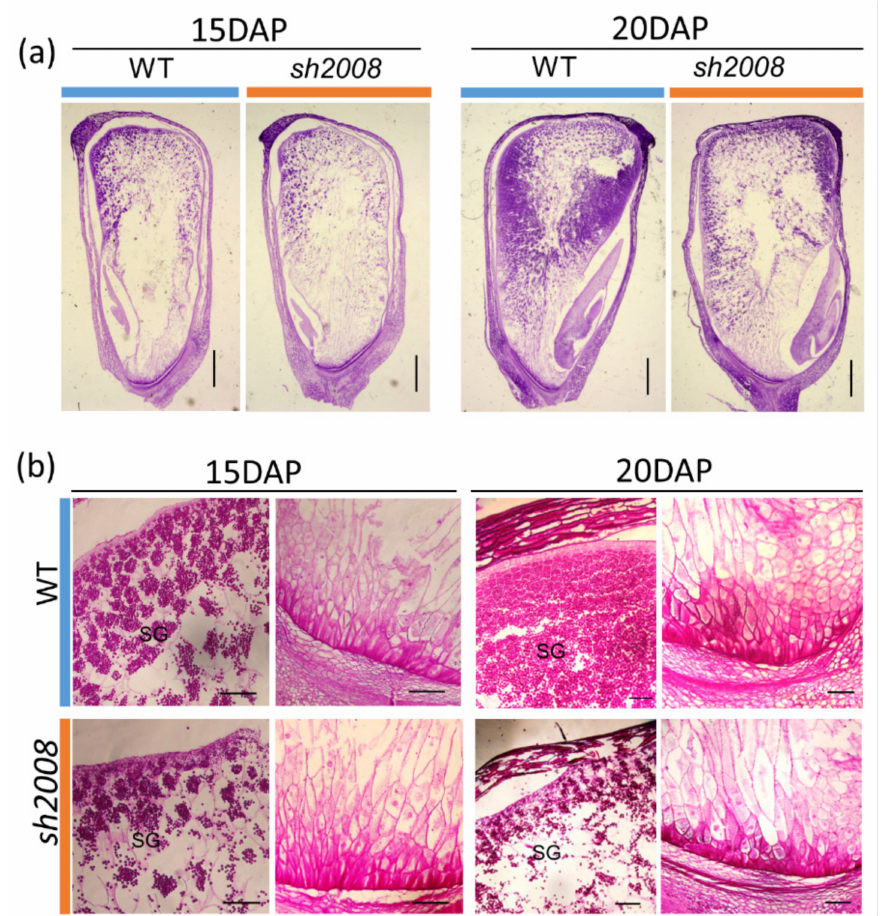
Figure 2. Light microscopy analysis of the immature kernel from the sh2008 and WT at 15 DAP and 20 DAP. ( a ) Light microscopy of paraffin sections of the WT and sh2008 kernels harvested from the same ears at 15 DAP and 20 DAP, respectively. ( b ) Microstructure of developing endosperms to show the starch granules (SG) and basal endosperm transfer cells (BETCs) of the WT and sh2008 at 15 DAP and 20 DAP, respectively. SG, starch granule. Scale bar, 1